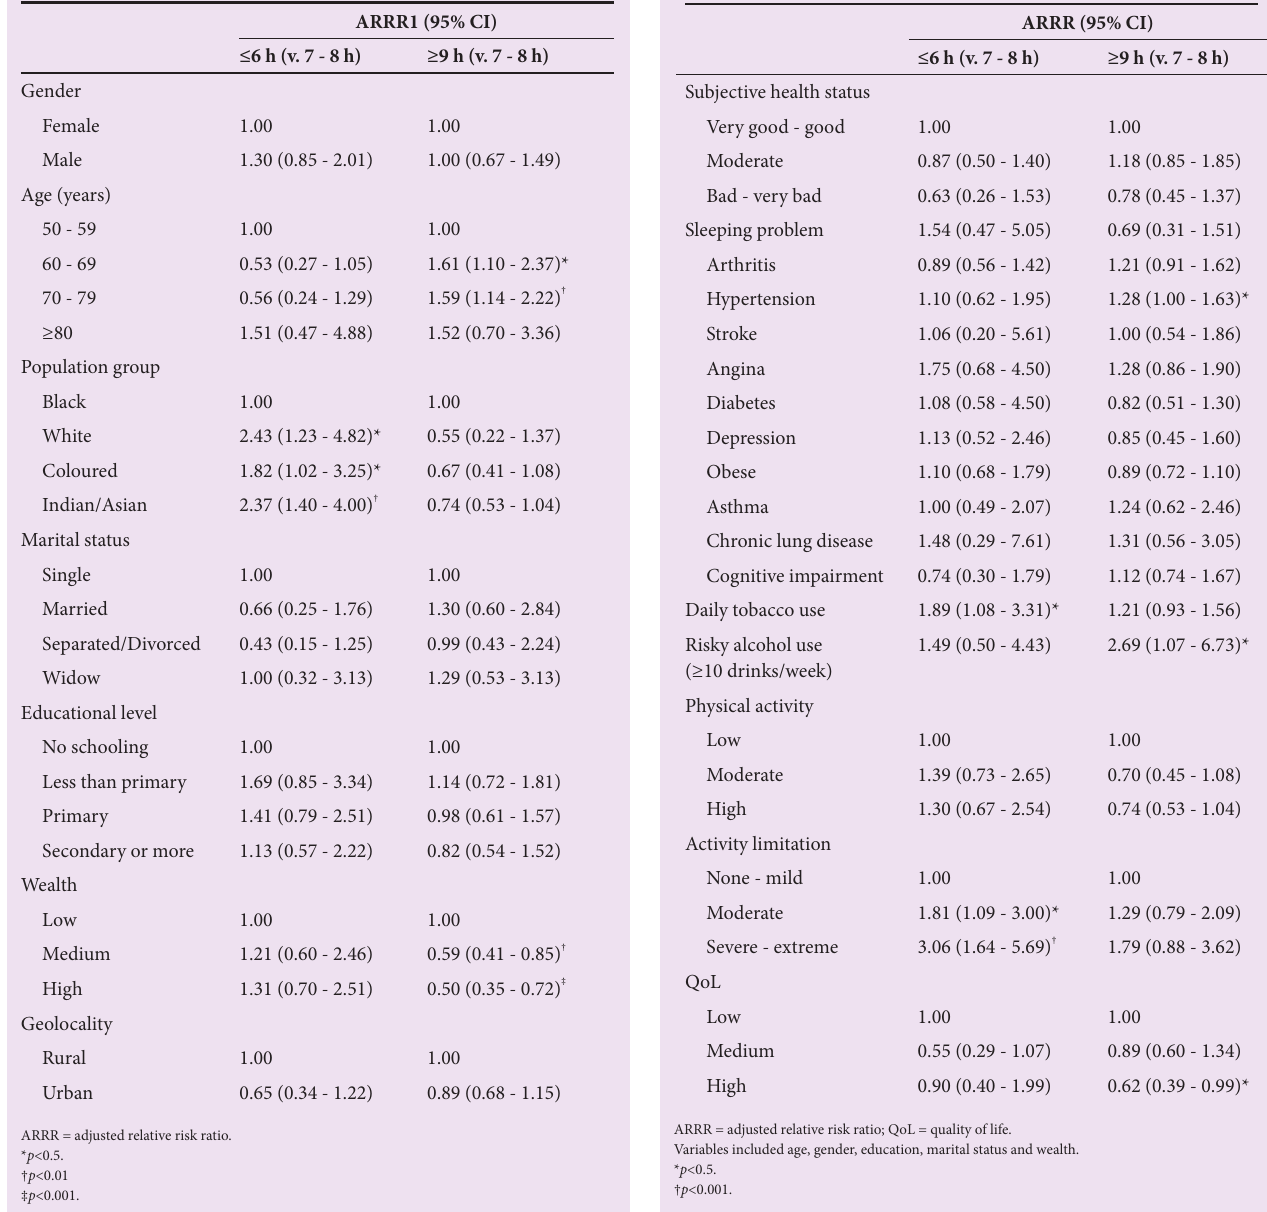
Table 3. Multinomial logistic regression with sleeping duration and sociodemographics in older South